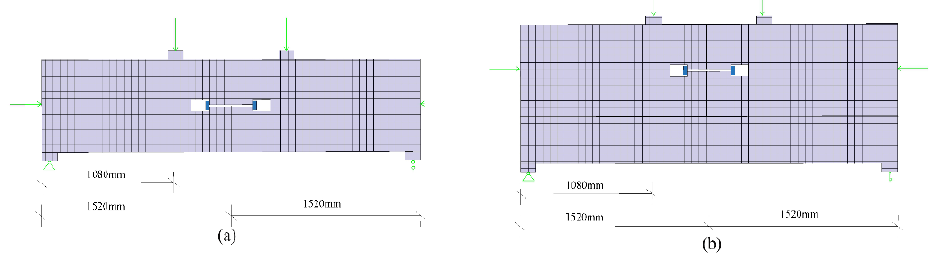
Figure 2. Two-dimensional sketch showing loading of the single-layer lining, ( a ) double-layer lining, and ( b ) segmental joint.